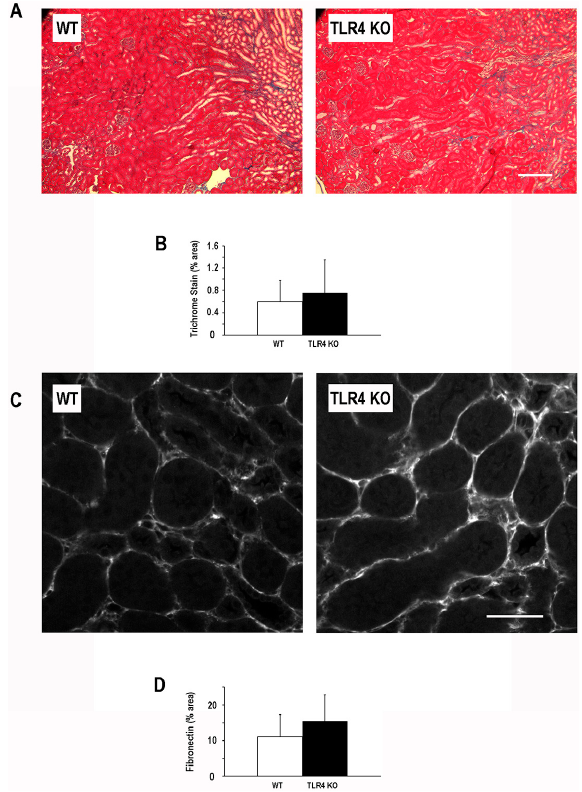
Figure 4. Deletion of TLR4 did not significantly alter the development of fibrosis following an episode of ischemic AKI. Panel ( A ) demonstrates representative trichrome images for WT and TLR4-deletion (TLR4 KO) mice at six weeks following a 19-min bilateral renal artery clamp; scale bar = 100 µm; Panel ( B ) shows quantitation of collagen/fibrosis (blue) on trichrome stained images (percent total area staining blue/field ±SD; 5–7 fields/animal; n = 4); Panel ( C ) demonstrates representative images of fibronectin immunostaining for WT and TLR4-deletion (TLR4 KO) mice at six weeks following a 19-min bilateral renal artery clamp; Scale bar = 50 µm; Panel ( D ) shows quantitation of fibronectin immunostaining on (percent total area staining positive for fibronectin/field ±SD; 5–7 fields/animal; n = 4).